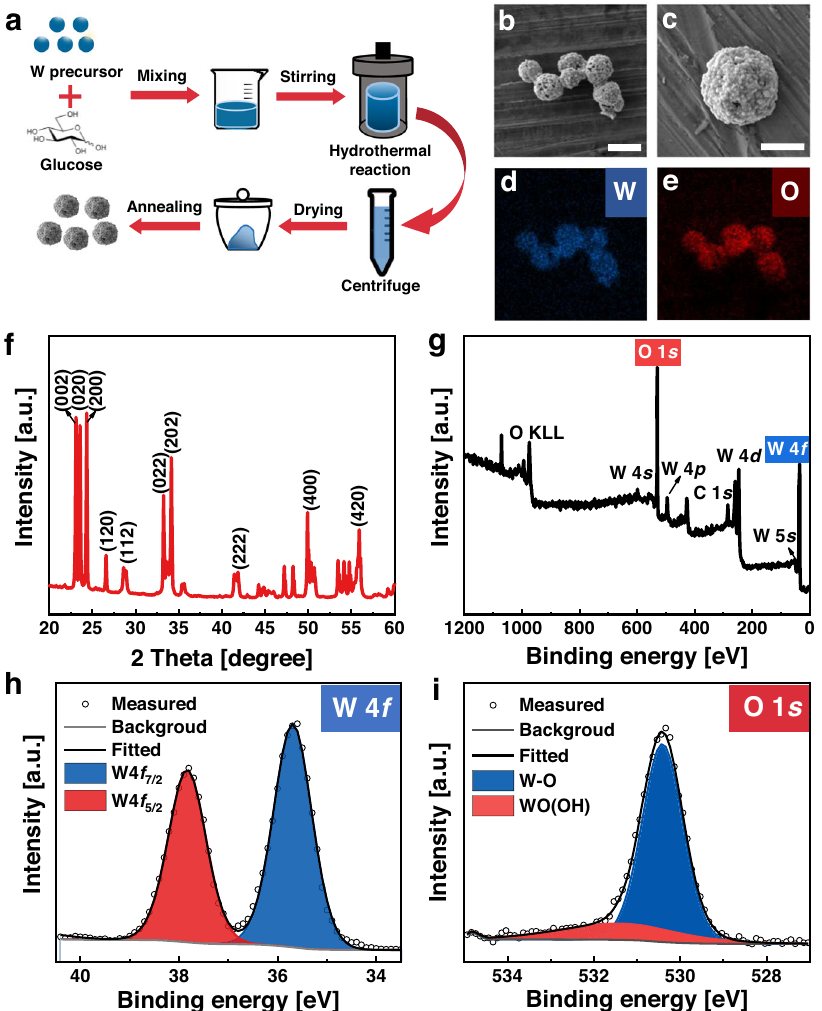
Fig. 1 The preparation process and characterization of WO 3 micromotors. a Schematic illustration of the preparation of WO 3 microspheres by hydrothermal and calcination processes. b (the scale bar is 2 µm) and c (the scale bar is 1 µm) SEM images of WO 3 micromotors. Elemental mapping images for d W and e O. f XRD pattern. g XPS wide spectrum. h High-resolution W 4 f XPS spectrum. i High-resolution O 1 s XPS